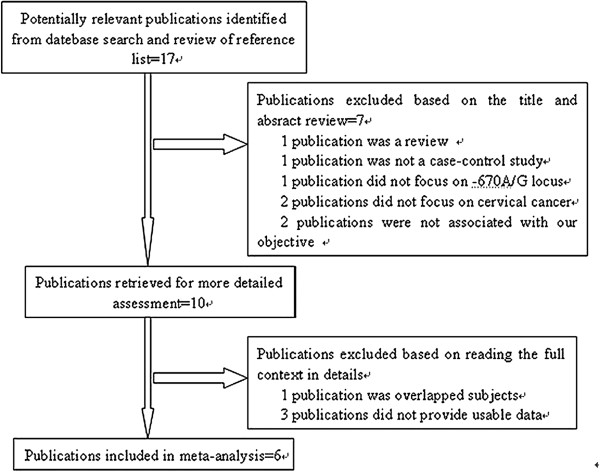
The forest plot describing the meta-analysis with a fixed-effect recessive model (G versus A) for the association of Fas rs180082 polymorphism with cervical cancer. Each study is depicted with size inversely proportional to its variance, accompanied by the respective 95% confidence intervals. Values of OR > 1, implied an increased risk for cervical cancer with the G allele.